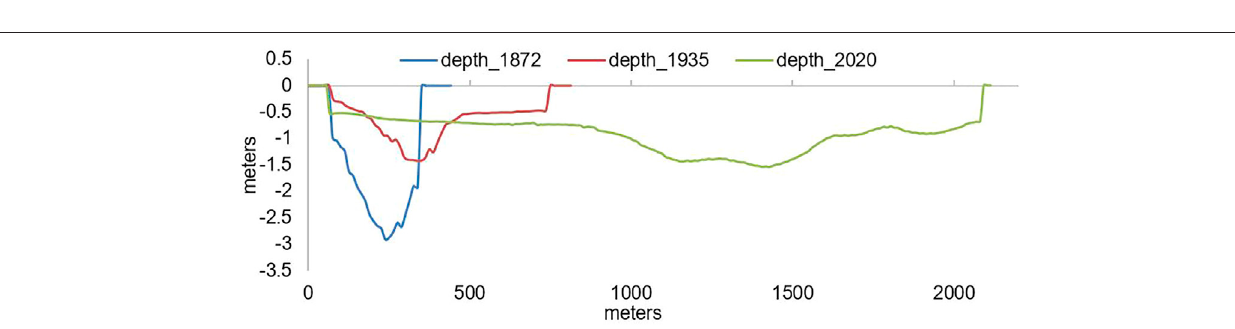
Frontiers in Built Environment |